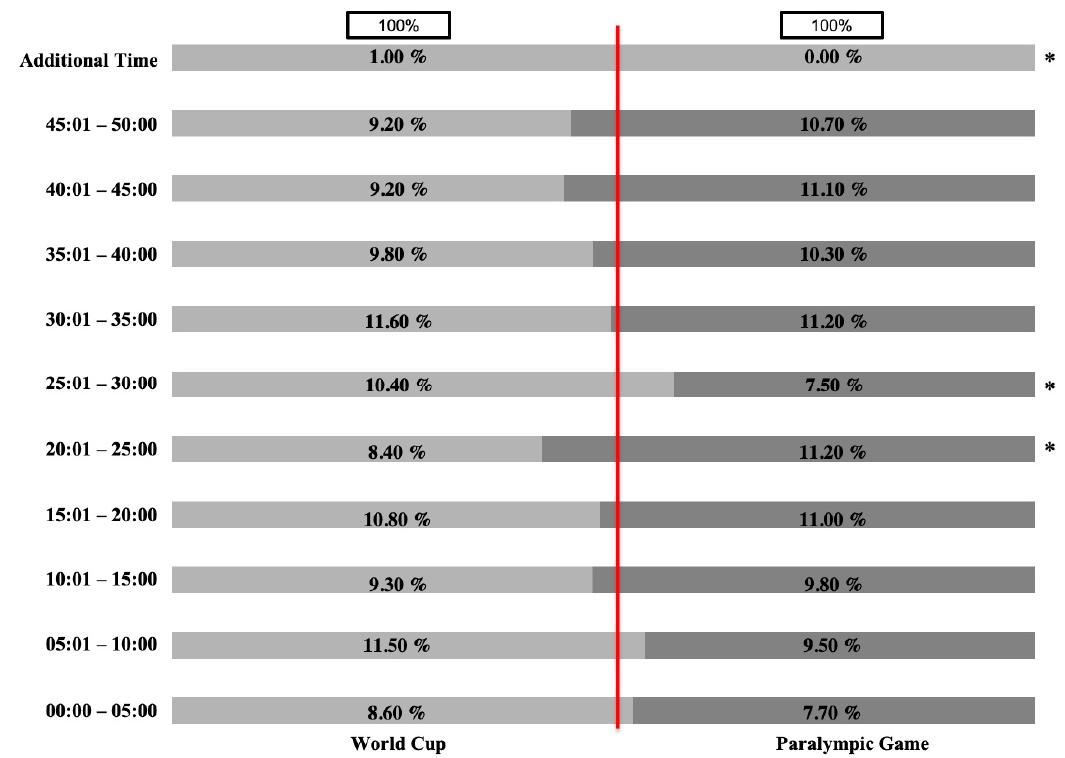
Figure 2. Distribution of goal throws according to the throwing moments by competition. * ASR > |1.96|.